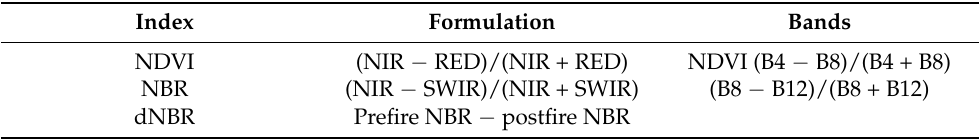
Table 2. Spectral indices tested in the study, and their formulation and related spectral bands (band numbering refers to the Sentinel-2 sensor system).